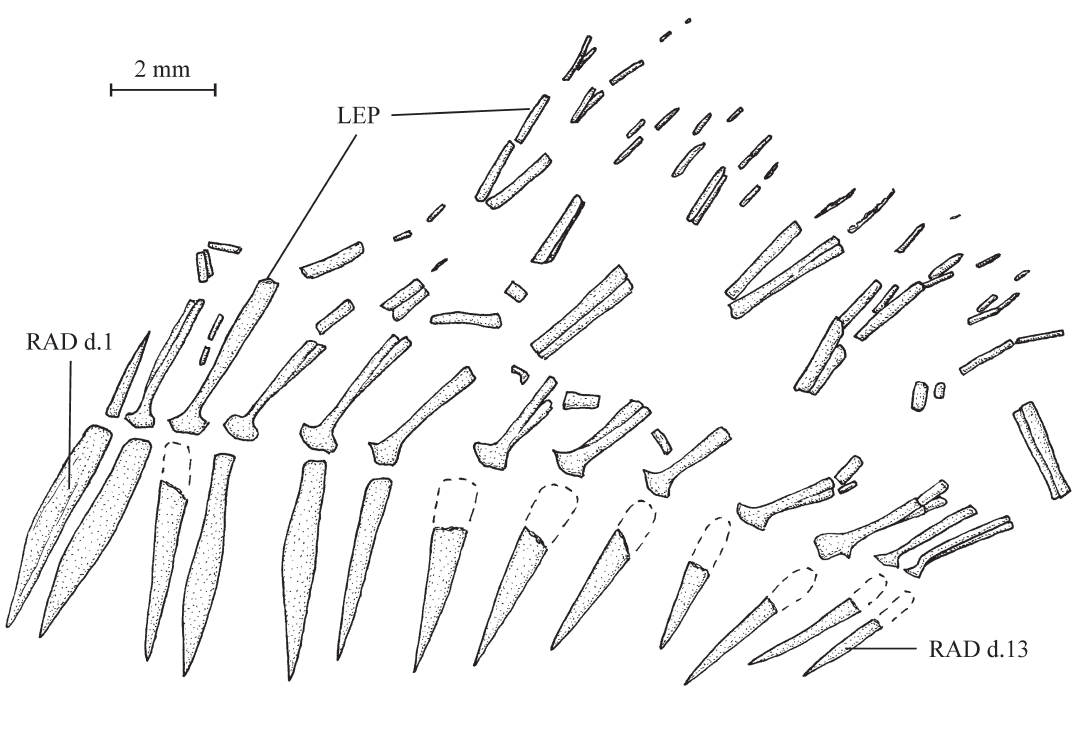
Fig. 11. Monocerichthys scheuchzeri gen. et sp. nov. The dorsal fin of holotype CLC